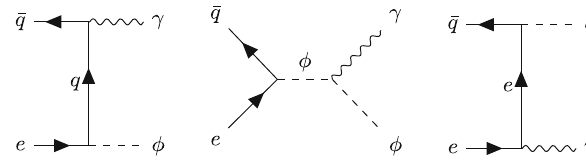
Fig. 1 Feynman diagrams for e ¯ q → γ